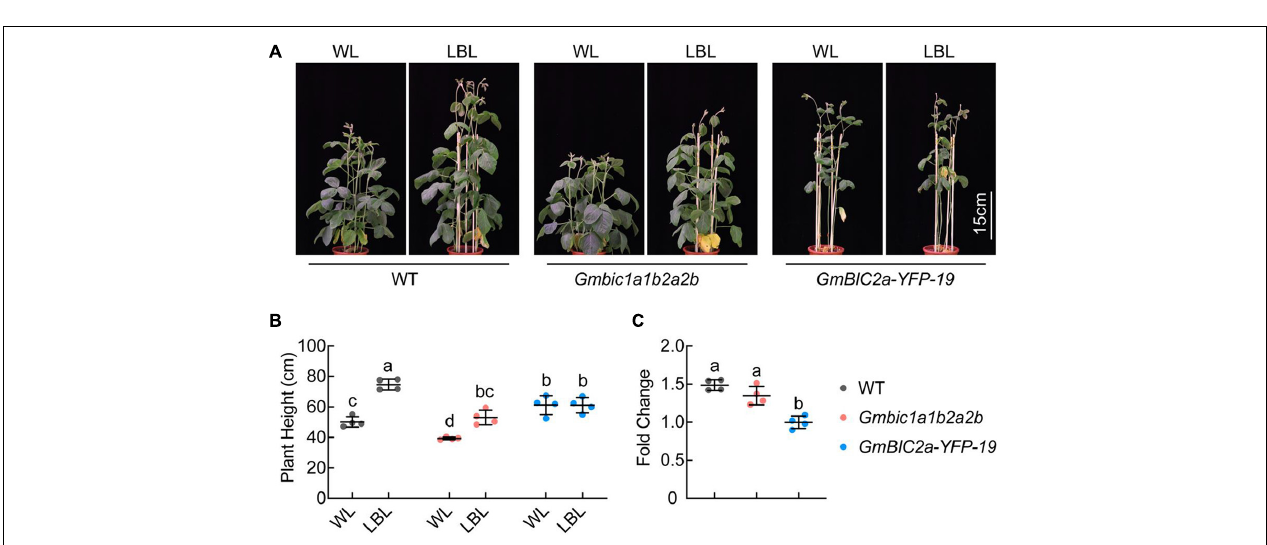
FIGURE 5 | GmBICs involved in LBL-induced stem elongation in soybean. (A) Representative images of the indicated lines grown under WL and LBL conditions. De-etiolated 10-day-old seedlings were treated with the indicated light regimes for 14 days under long-day conditions. Scale bar = 15 cm. (B) Statistical analysis of the plant height of each line in (A) . Data are means ± SD ( n = 4). The lowercase letters indicate significant differences ( p < 0.05, two-way ANOVA with Tukey’s multiple comparisons test). (C) Statistical analysis of fold change in plant height of each line grown under LBL relative to that under WL, as in (A) . Data are the means ± SD ( n = 4). The lowercase letters indicate significant differences ( p < 0.01, one-way ANOVA with Tukey’s multiple comparisons test). WL, white light; LBL, low blue light.